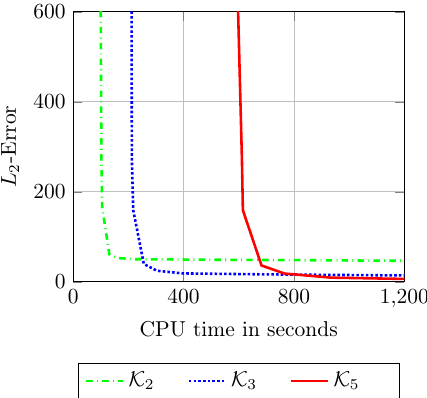
Figure A3. Results of the two-dimensional GES experiment without source: comparison of the L 2 - error and the corresponding CPU time using KSMOR at t F = 2.609 by constructing subspaces with (cid:101) w ( t ) computed using EE. The results are accurate, but also linked to extremely high computational